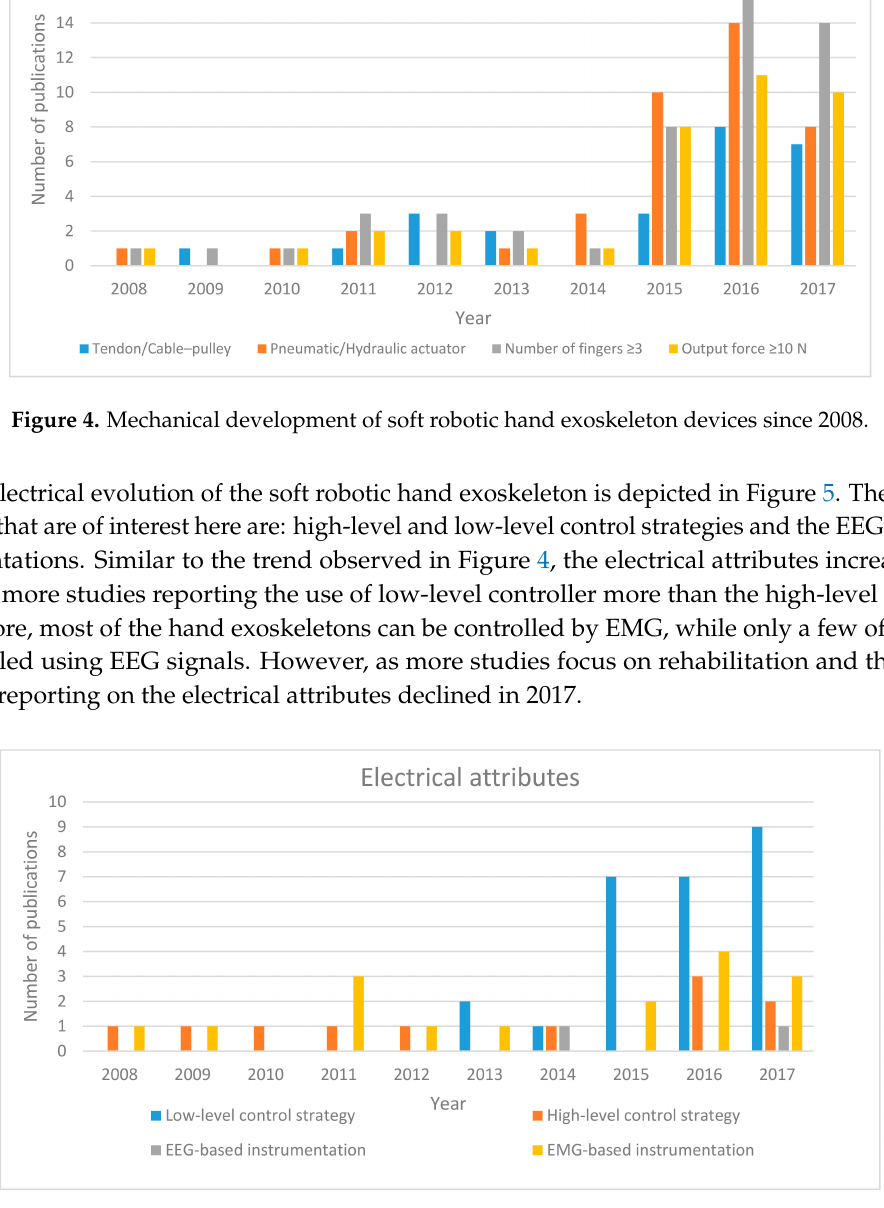
Figure 5. Electric development of soft robotic hand exoskeleton devices since